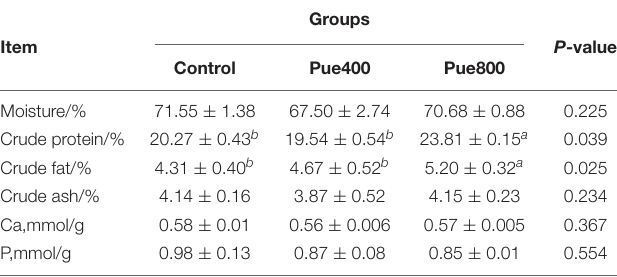
TABLE 4 | Effect of Puerarin on the nutritional components of muscle in beef cattle under heat stress.